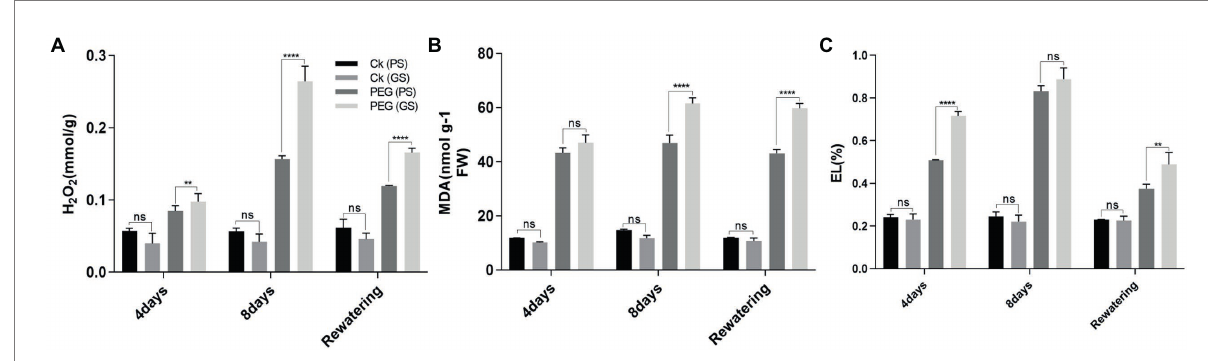
FIGURE 5 Purple and green stem Brassica napus plants under drought (10% PEG-6000), (A) hydrogen peroxide (H 2 O 2 ), (B) malonaldehyde (MDA), and (C) membrane stability index: elelectrolyte leakage (EL), respectively. Different symbols represents significance level as * p = 0.05, ** p = 0.01, *** p = 0.001, **** p = 0.0001. ns, non-significance.